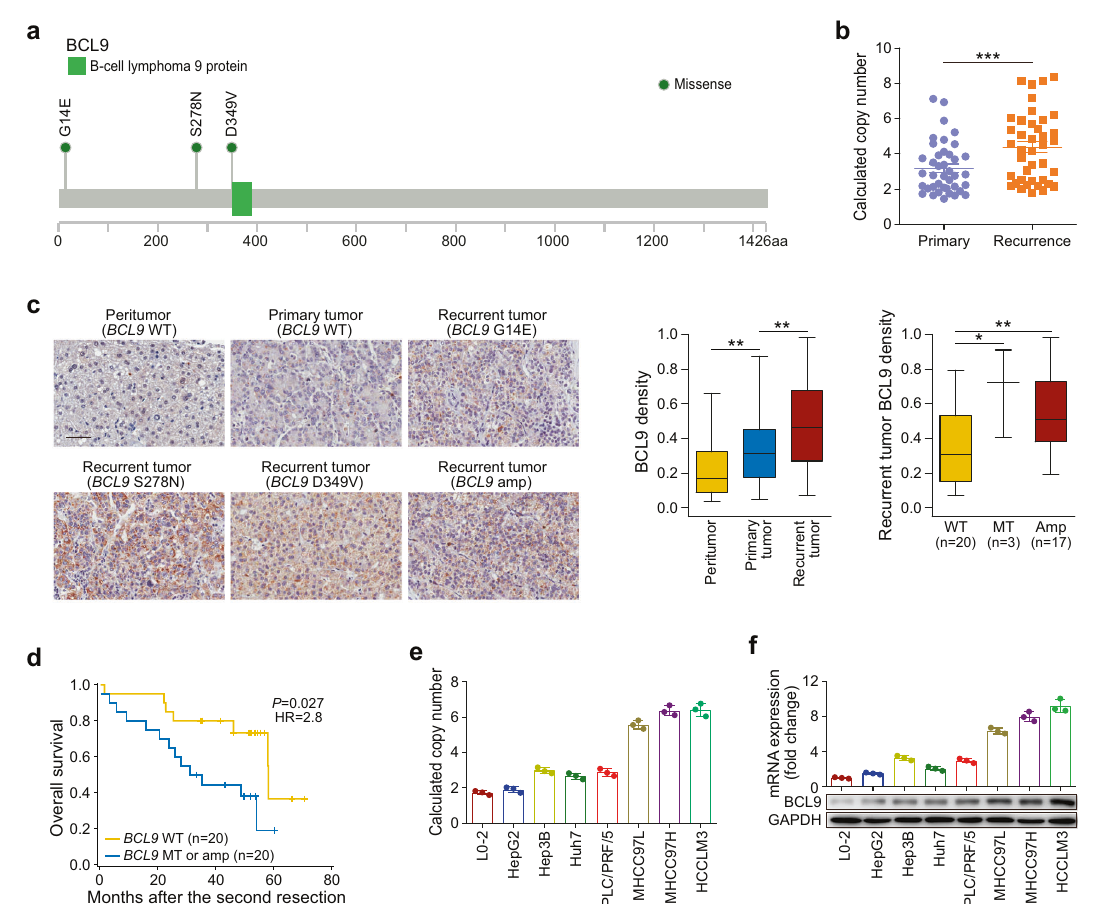
Fig. 7 Clinical signi fi cance of BCL9 genomic alteration in 40 pairs of primary and recurrent HCCs. a Distribution of somatic mutations in BCL9 identi fi ed in the recurrent HCC samples. b Calculated BCL9 copy numbers identi fi ed in 40 pairs of primary and recurrent HCCs, *** P < 0.001. c Representative BCL9 staining and its density statistics in peritumor tissues, primary tumor tissues with wild-type BCL9 , and recurrent tumor tissues with mutant BCL9 (G14E, S278N, and D349V) and BCL9 ampli fi cation; scale bars = 50 μ m, * P < 0.05, ** P < 0.01. d Kaplan − Meier survival analysis showing overall survival rates after the second resection based on BCL9 mutation and copy-number variation in recurrent tumors. e BCL9 copy numbers revealed by qPCR in one normal liver cell line (L0-2) and six HCC cell lines. f BCL9 mRNA and protein levels examined by qRT-PCR and western blot in one normal liver cell line and six HCC cell